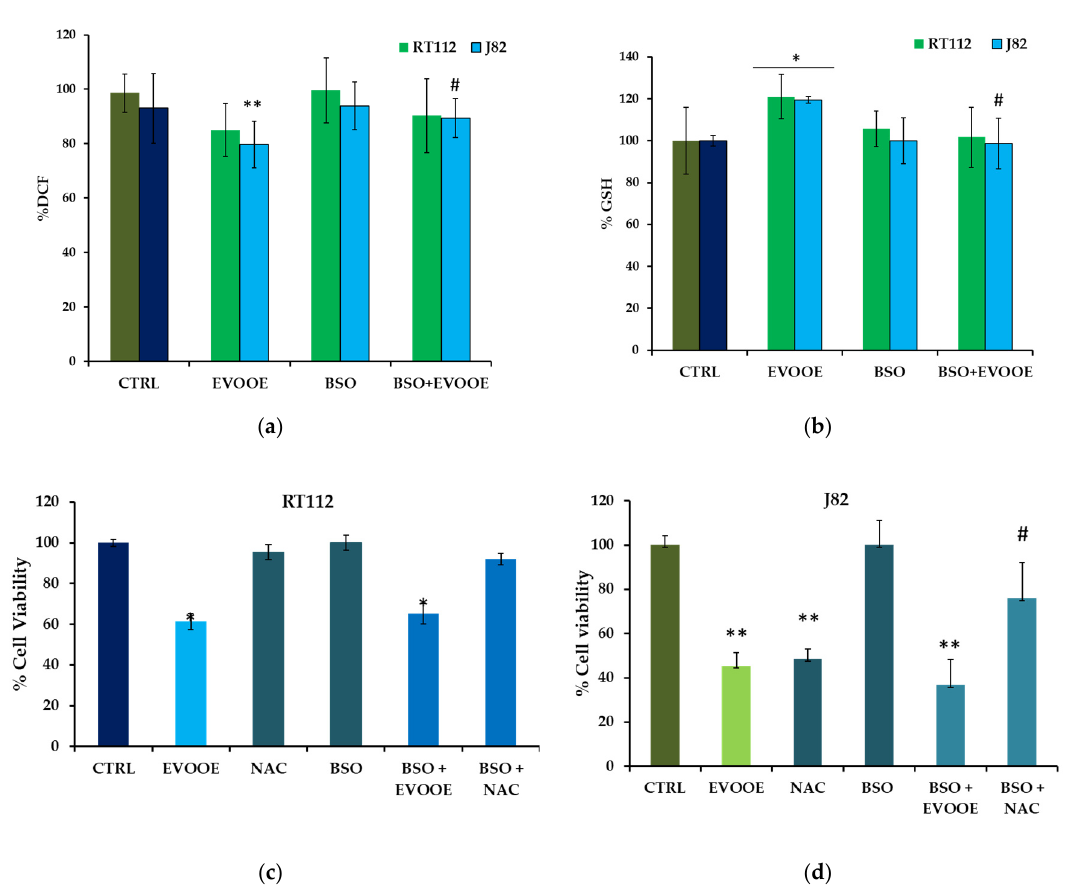
Figure 7. Absence of correlation between antioxidant and anti-proliferative effect induced by EVOOE in bladder cancer cell lines. RT112 and J82 cells were pre-treated for 3 h with BSO (0.5 mM) and subsequently with 66 mg/mL of extract for 3 h to detect GSH content ( a ) and for 30 min to measure intracellular ROS ( b ). RT112 ( c ) and J82 ( d ) cells were pre-treated for 3 h with BSO (0.5 mM) and subsequently with 132 mg/mL and 66 mg/mL of EVOOE, respectively, or NAC (60 mM) for 24 h. Cell viability was assessed by Crystal Violet assay, as reported in the Materials and Methods section. Bar graphs represent the mean of three experiments (±s.e.). Symbols indicate significance: p < 0.05 (*), p < 0.005 (**) with respect to CTRL In panel ( a ) p < 0.05 (#) with respect to EVOOE single treatment and in ( d ) p < 0.05 (#) with respect to NAC treatment.